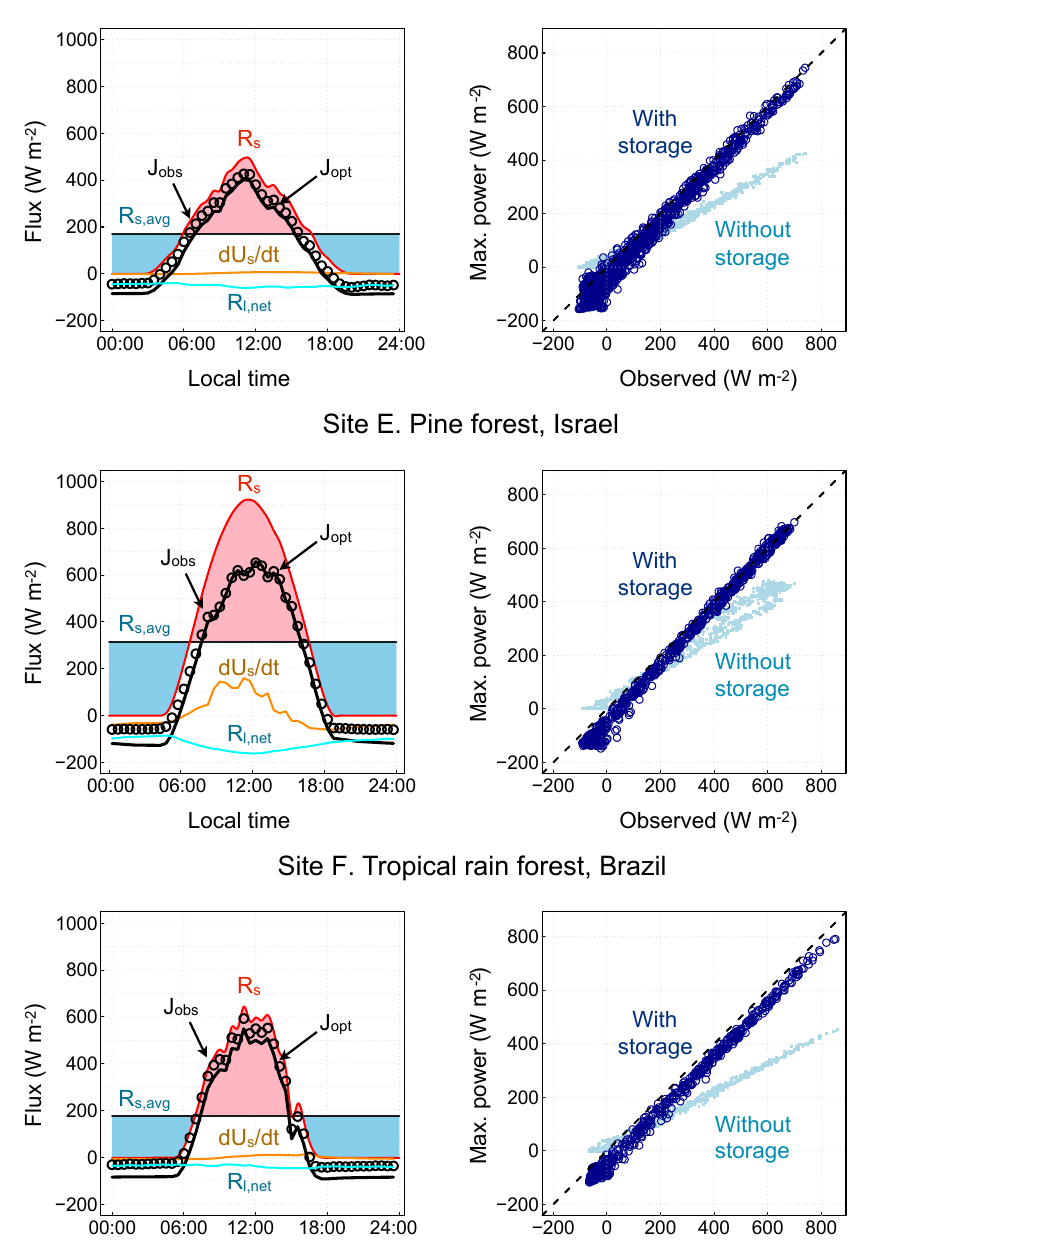
Figure 3. Mean diurnal cycle of the absorption of solar radiation at the surface ( R s , red line, observed), ground heat flux (d U s / d t , orange line, observed), and turbulent heat fluxes estimated by maximum power ( J opt , black line, estimated) and observations ( J obs , black circles, observed) for a selected month for six field observations in (a) a tundra ecosystem in Alaska, (b) a cropland in the midwestern US, (c, d) a grassland and pine forest in a temperate environment in Germany, (e) a planted pine forest in an arid environment in Israel, and (f) a tropical rain forest in the humid Amazon Basin in Brazil. The comparison of the turbulent heat fluxes estimated from maximum power to energy balance measurements is shown for 30min observations in the right panel for each site for two cases of thermodynamic limits that differ by their consideration of heat storage changes (dark blue: with storage, as in Eq. (4); light blue: without storage, i.e., d U s / d t = 0 and d U a / d t = 0 so that J opt = R s / 2). More information on the sites and the correlation statistics are provided in Table